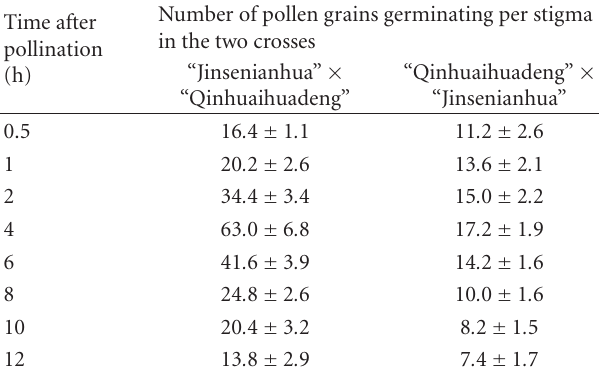
Table 1: Number of pollen grains germinating on stigma after pol- lination. Time